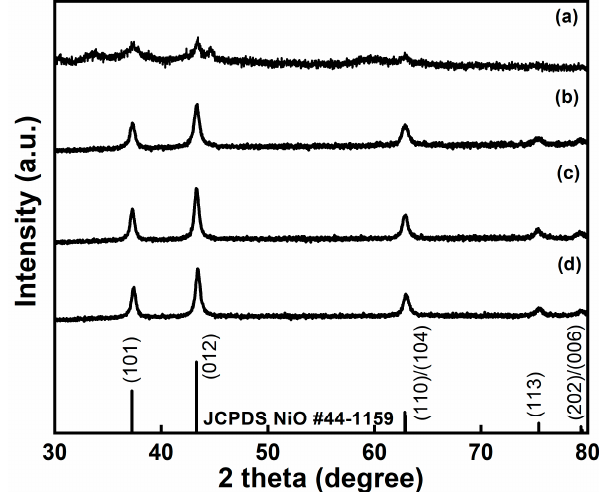
Figure 6. XRD patterns of ternary metal oxides obtained from flame-assisted spray pyrolysis using: ( a ) 0.5 M, ( b ) 1.0 M, ( c ) 1.5 M, and ( d ) 2 M precursor solution.